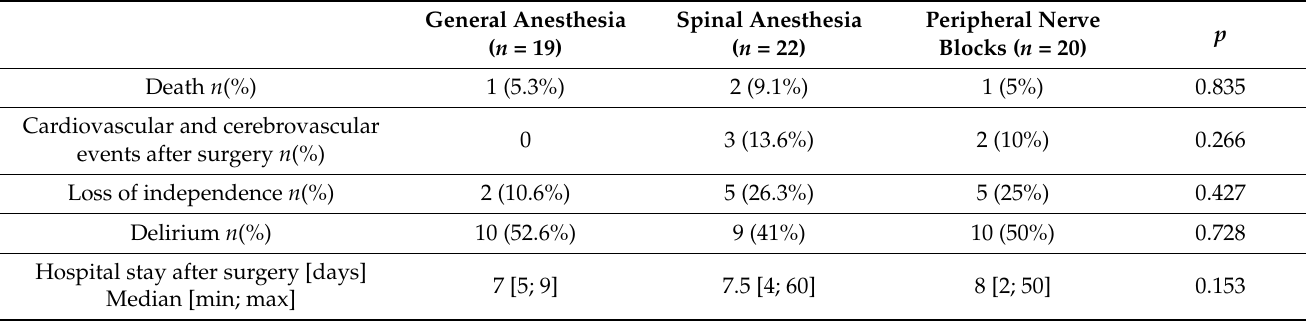
Table 3. Results of the